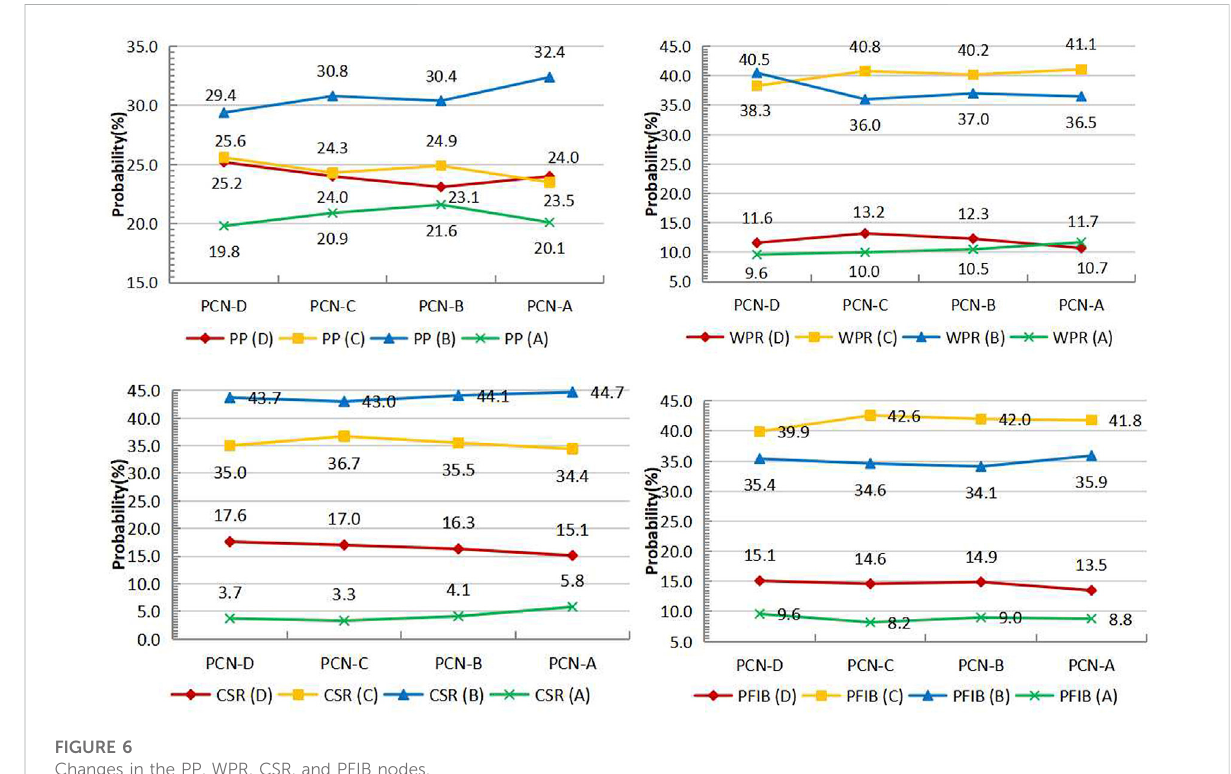
FIGURE 6 Changes in the PP, WPR, CSR, and PFIB